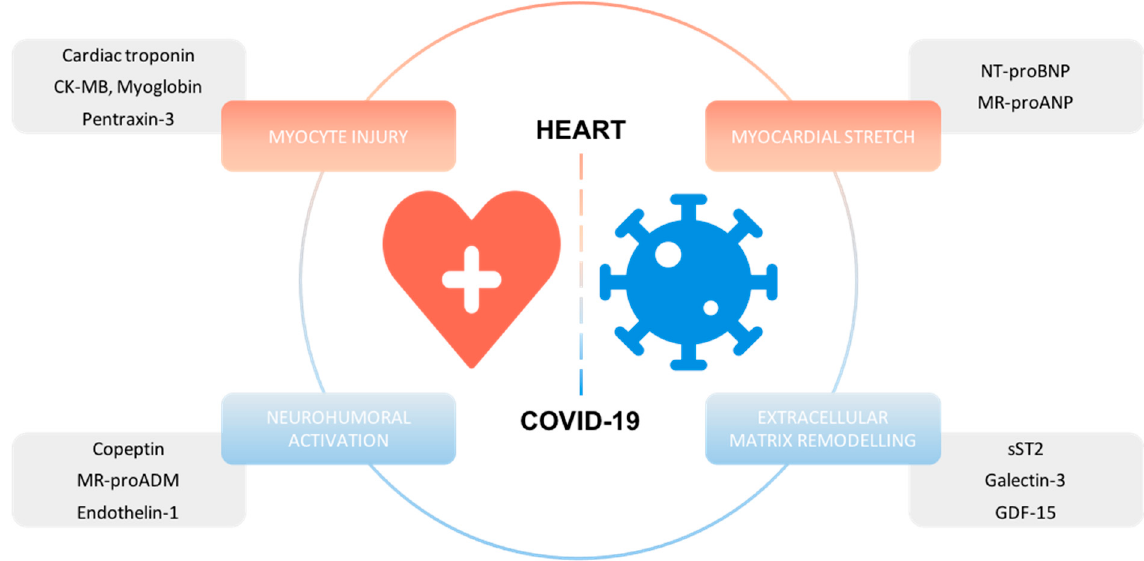
Figure 2. Overview of cardiac biomarkers with prognostic information in COVID-19. Table 1. Characterization of Cardiac Biomarkers by Primary Origin, Release Mode, Normal Range and Mortality Prediction in COVID-19.